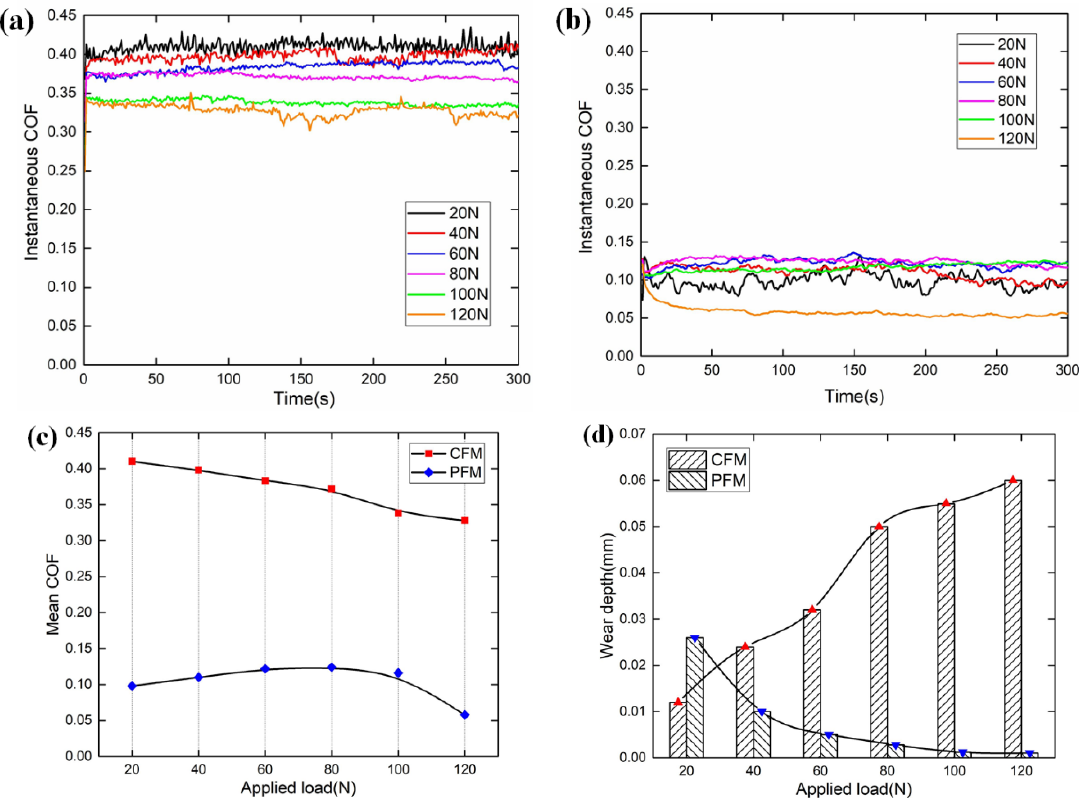
Figure 5. Experimental results under the applied load condition. ( a ) Instantaneous COF of CFM; ( b ) instantaneous COF of PFM; ( c ) mean COFs of the CFM and PFM; ( d ) wear depths of the CFM and PFM.